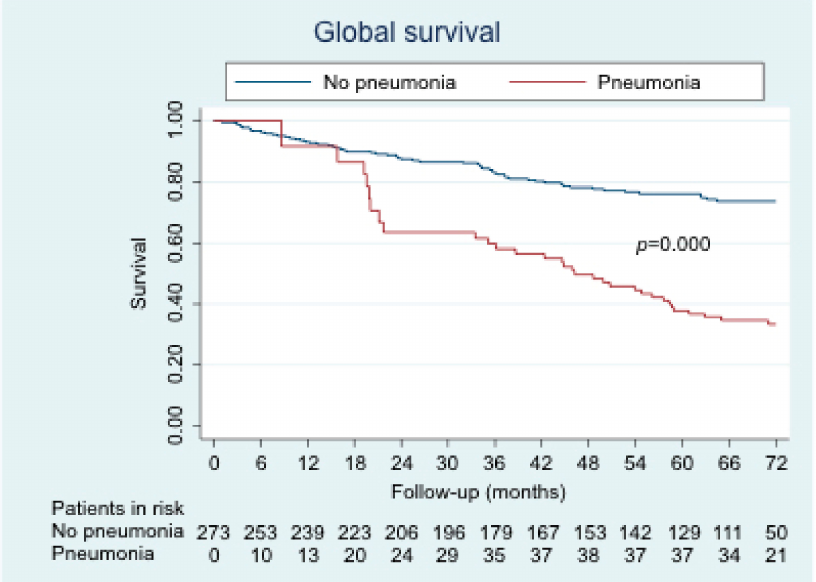
Figure 1. Overall survival according to the presence or absence of pneumonia.